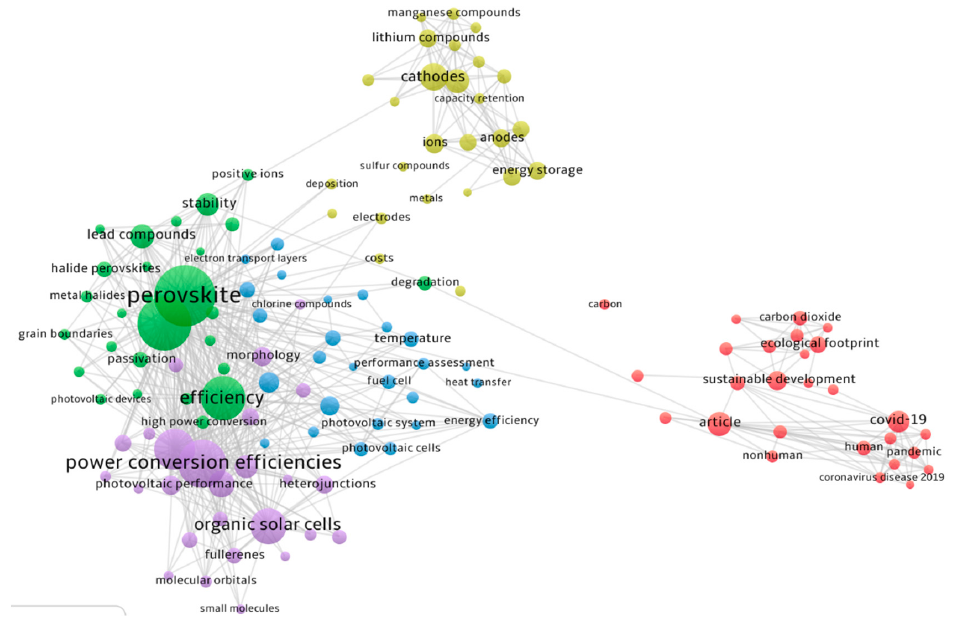
Figure 7. Network map of research topics for the top 5 publications on renewable energy, sustainability and the environ- ment, 2020–2021 (Based on the SciVal database (www.scival.com, accessed on 7 April 2021); data source: Scopus (down- loaded on 7 April 2021); copyright: Elsevier B.V.).